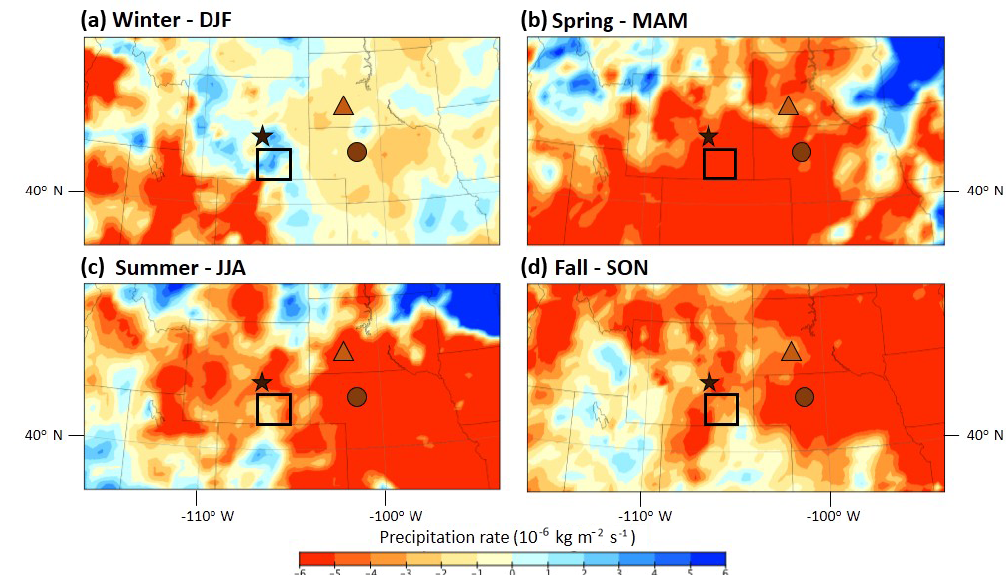
Figure 5. Composite-anomaly maps for precipitation rate at the surface during (a) winter (DJF); (b) spring (MAM); (c) summer (JJA); and (d) fall (SON). Positive values (cool colours) for precipitation rate indicate wetter-than-normal conditions. Negative values (warm colours) indicate drier-than-normal conditions. The black box denotes the study site, Long Lake in the Medicine Bow Mountains of south- eastern Wyoming. The black star denotes the Ferris and Casper dune fields; the orange triangle denotes the White River Badlands dunes; and the brown circle denotes the Nebraska Hills sand dunes. Light grey lines depict lines of latitude and longitude.